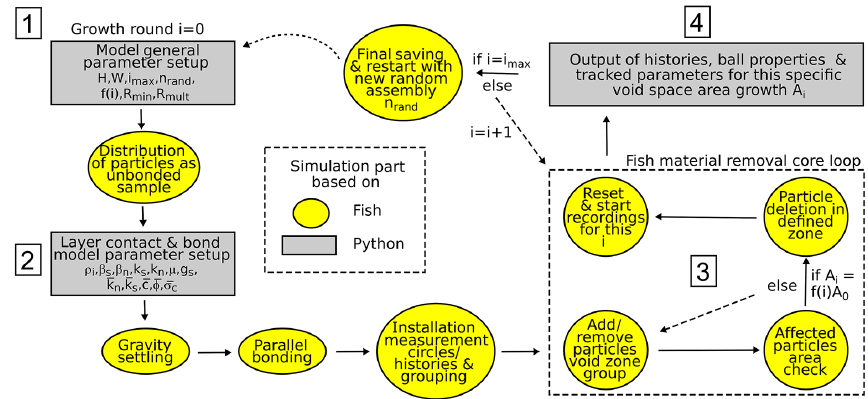
Figure B6. Graphical description of the PFC2D-based sinkhole modelling code. Yellow colours indicate PFC-Fish language-based code; grey colours are Python control connections. Solid arrows indicate time step cycling. Each model set consists of n rand random assemblies of particles to account for statistical variation of the DEM sinkhole collapse via arbitrary material removal function in single